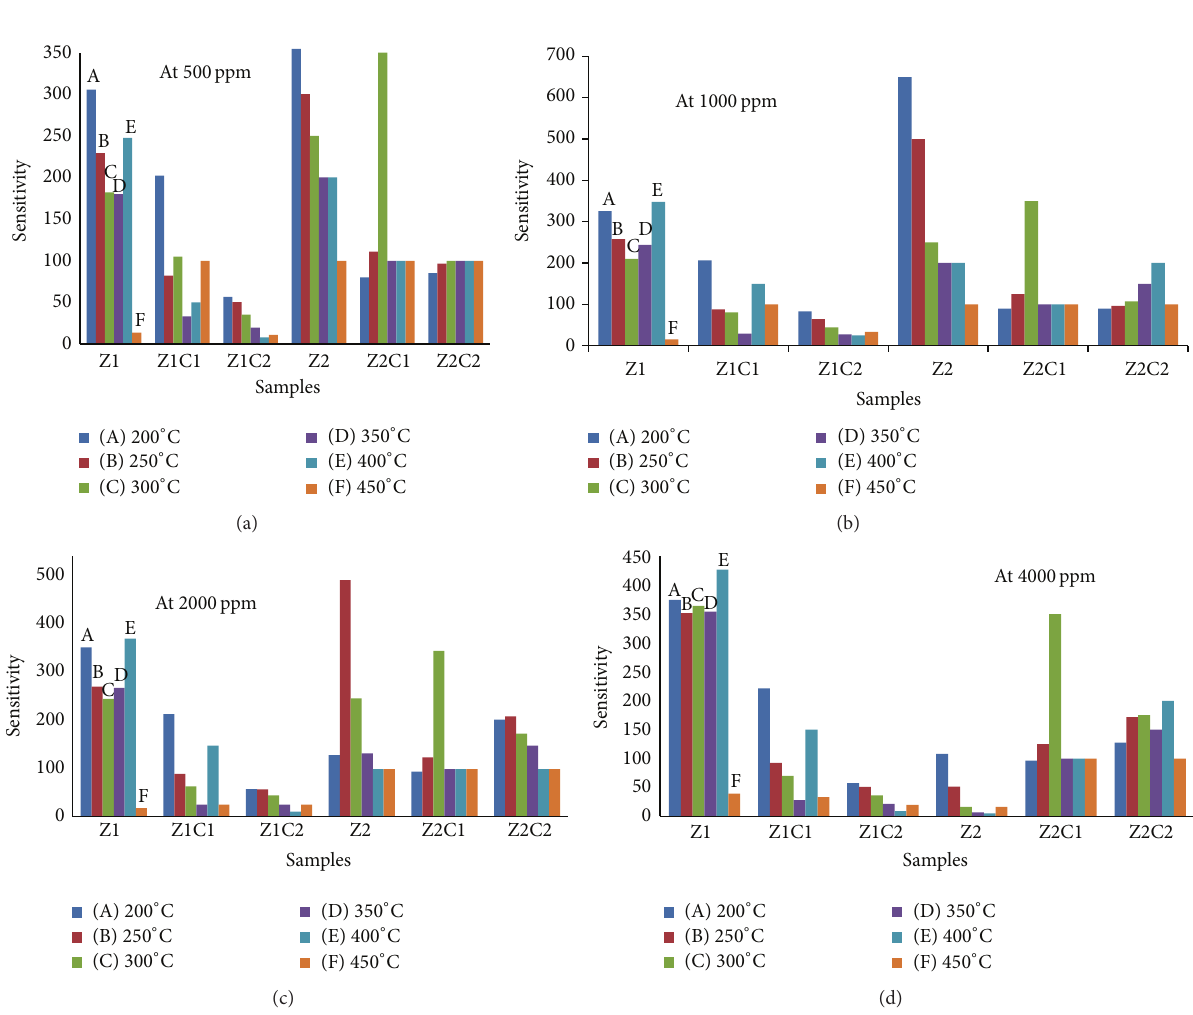
maximum at 200 ∘ C for all CO 2 concentrations from 500 to 4000